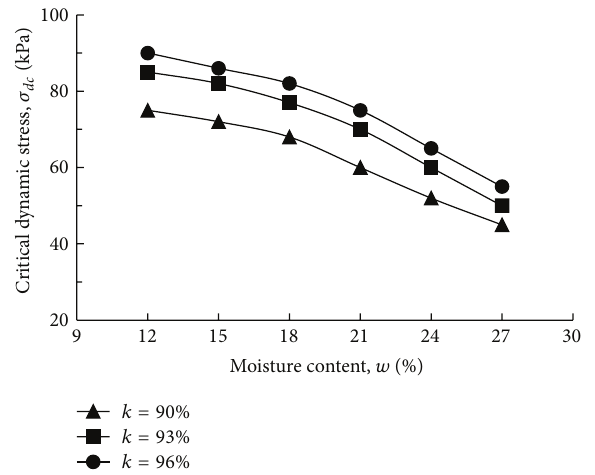
Figure 8: Critical dynamic stress versus moisture content for various degrees of